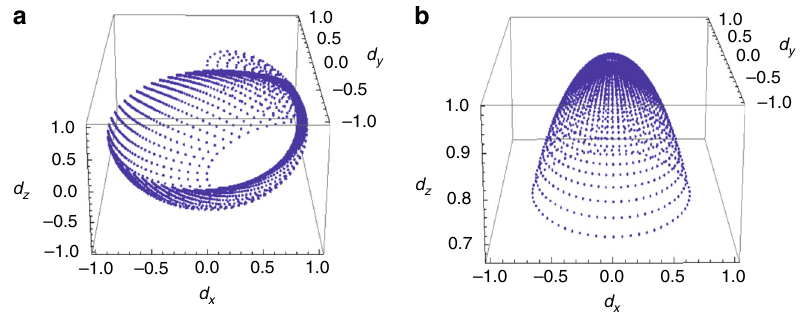
Fig. 2 The mapping of ^ d ð k Þ . a The mapping in the original spin basis. b The mapping in the chiral basis. The difference between the two situations shows that the two topological invariants are needed to completely characterize the p + ip excitonic insulator, i.e., ( C , C c ) =